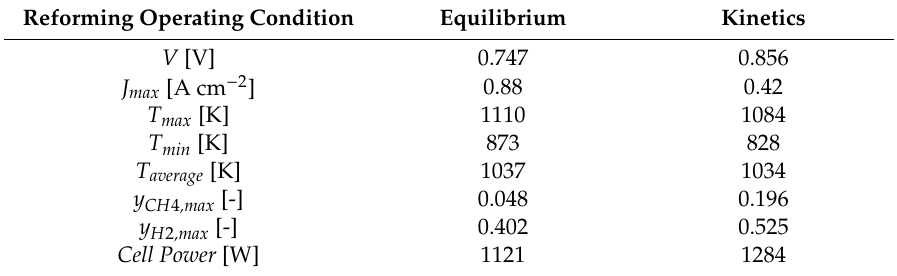
Table 5. Main results of di ff erent simulations basing on equilibrium and surface reaction mechanism